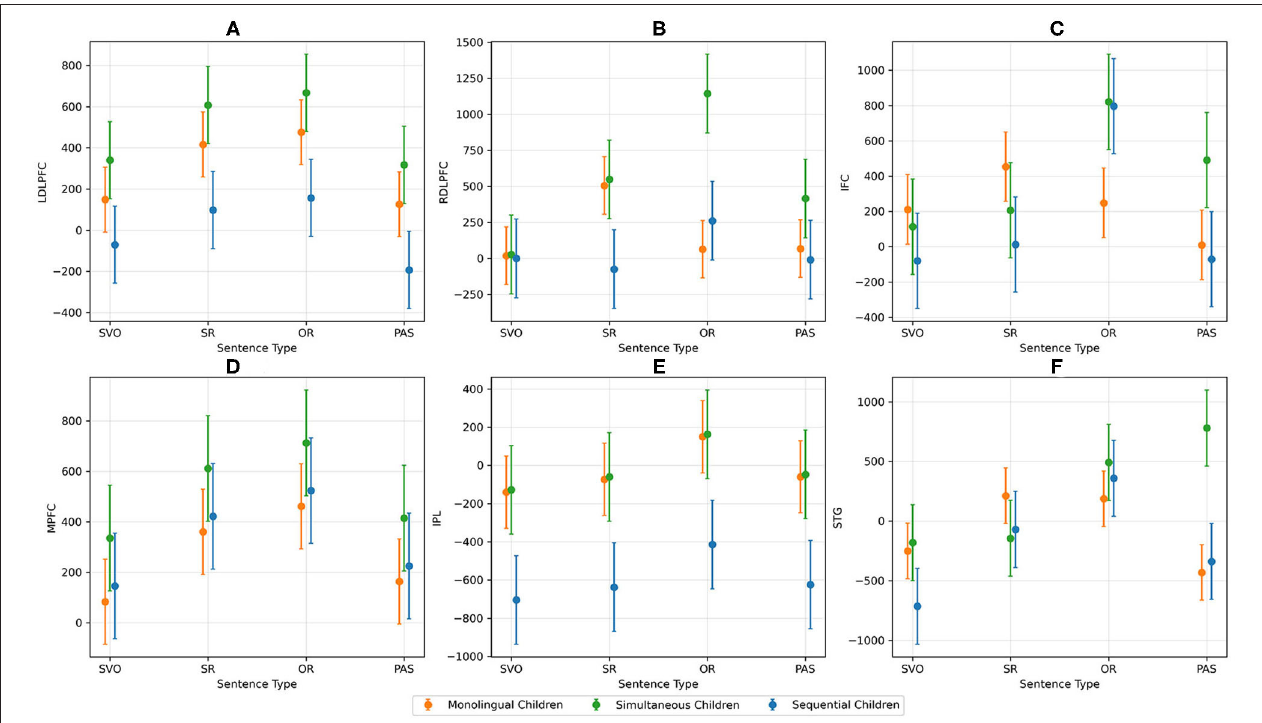
FIGURE 3 | AUC activation for each ROI and sentence type across monolingual, simultaneous, and sequential children. Picture (A) shows the AUC activation for left DLPFC, (B) shows the AUC activation for right DLPFC, (C) shows the AUC activation for left IFC, (D) shows the AUC activation for MPFC, (E) shows the AUC activation for left IPL, and (F) shows the AUC activation for left STG.